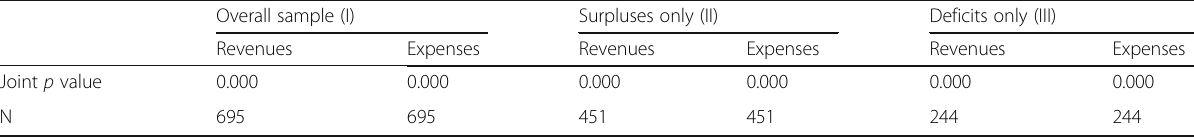
Table 3 Results for the simultaneous-equations model (Continued) Overall sample